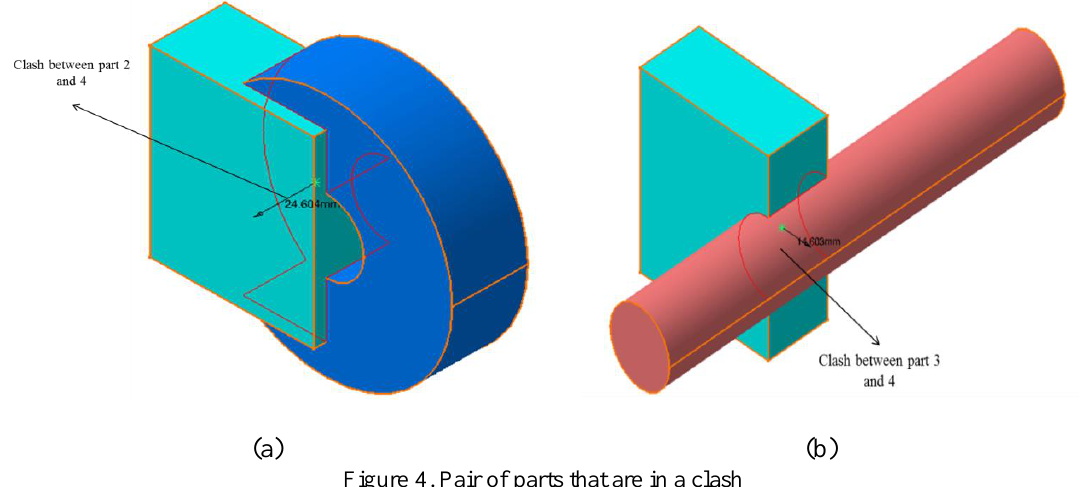
Figure 4. Pair of parts that are in a